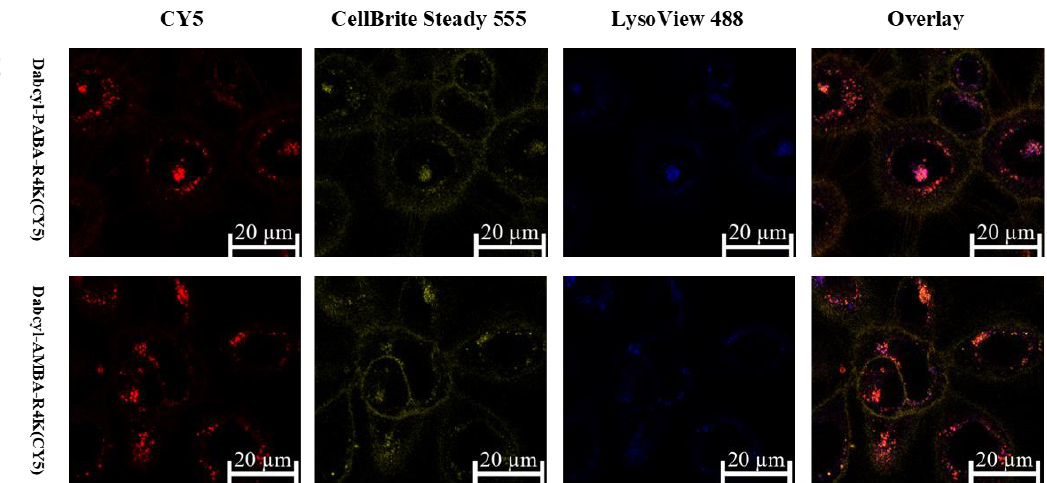
Figure 7. Cellular distribution of peptides on SCC-25 cells visualized by confocal microscopy. Cells were incubated with the CY5-labelled peptides for 1hr (Red). CellBrite Steady was used to stain the membrane (green). Nuclei were stained with NucSpot Live 488 (Figure 6A,B blue), lysosomes were stained with LysoView 488 (Figure 6C blue). Concentrations of the peptides were ( A ) 5 µ M, ( B ) 0.31 µ M and ( C ) 5 µ M in the three experiments. Imaging was performed by a Zeiss LSM 710 system.